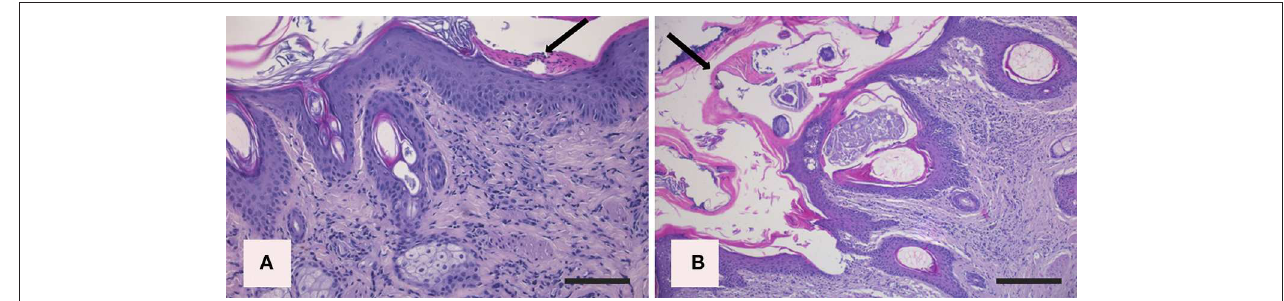
FIGURE 3 | Histopathologic lesions in northern chamois ( Rupicapra r. rupicapra ) affected by sarcoptic mange. The following pictures are further evidenced by black arrows: (A) Moderate, diffuse, irregular epidermal hyperplasia with neutrophilic serocellular crust in grade 2 sarcoptic mange (hematoxylin and eosin, bar = 300 µ m).